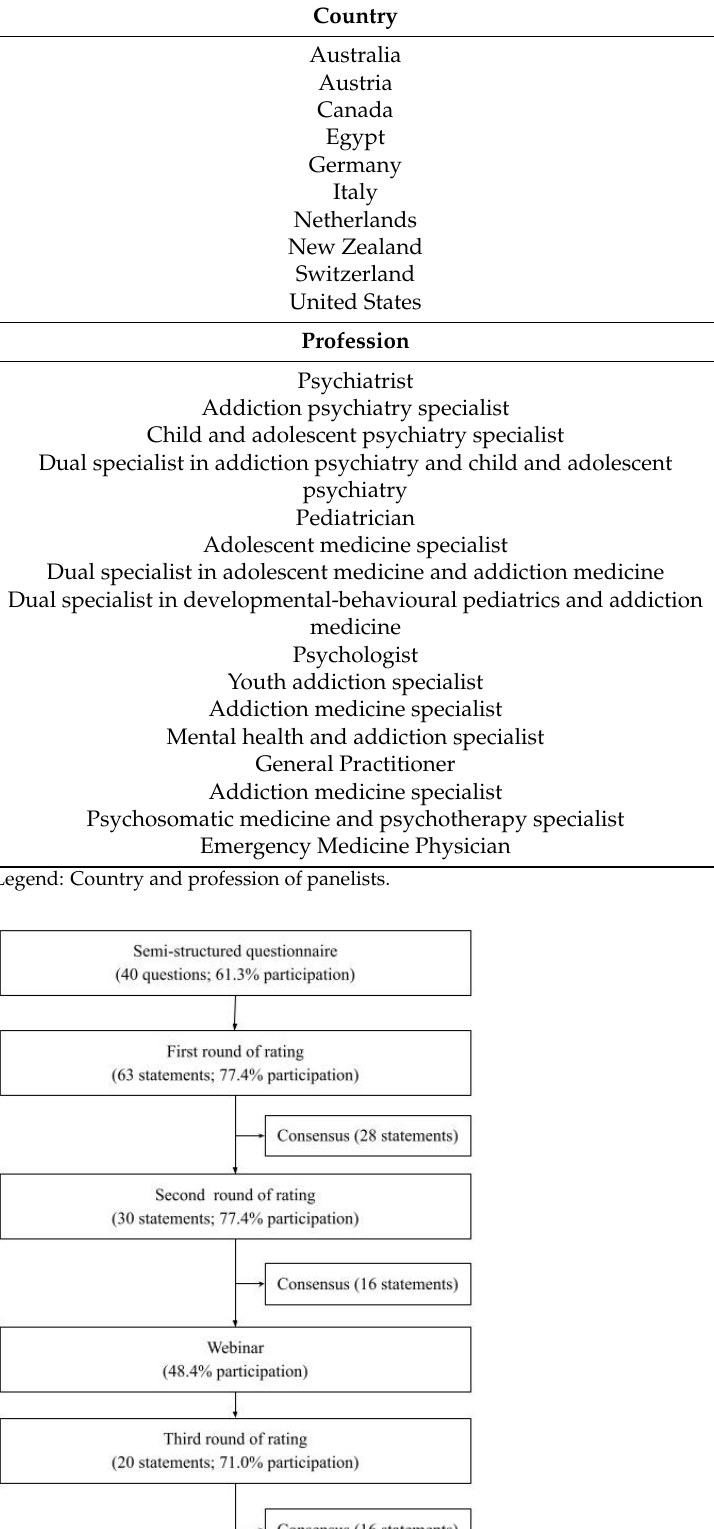
Table 1. Characteristics of panelists ( N = 31).